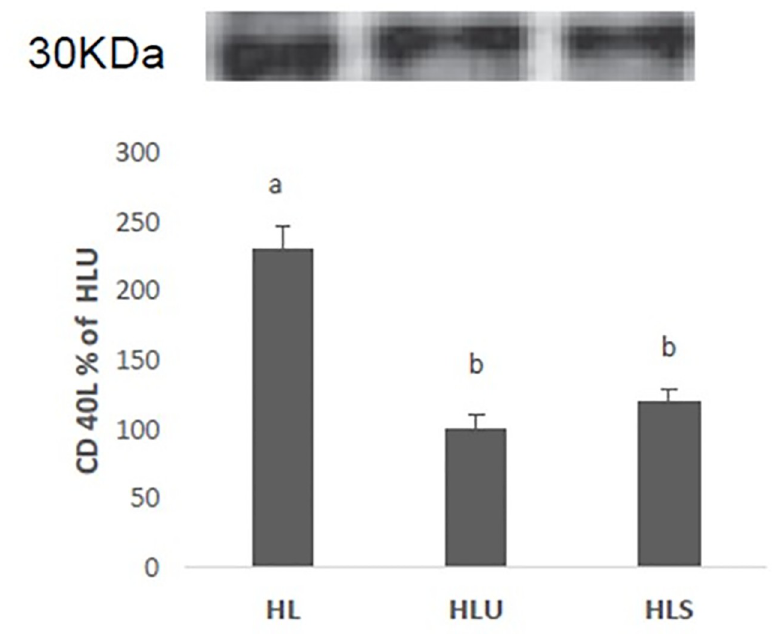
Fig 2. Western Blot analysis of the expression of the CD40 ligand protein (CD40L) LDLr -/- fed a high fat diet (HL), LDLr -/- mice fed a high fat diet and treated with grape juice (HLU), LDLr mice -/- fed a high-fat diet treated with simvastatin (HLS). Values expressed as mean ± standard error of the mean. (ANOVA + Tukey test).